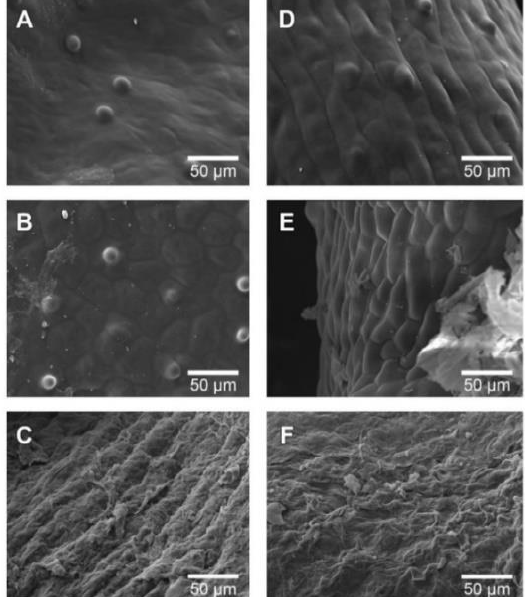
Figure 4. Microstructure of pieces of dried Physalis purée peel via SEM (500× ). Non-assisted RW ™ method at 60 °C ( A ), 75 °C ( B ), and 90 °C ( C ). IR-assisted RW ™ method 60 °C ( D ), 75 °C ( E ), and 90 °C ( F ).